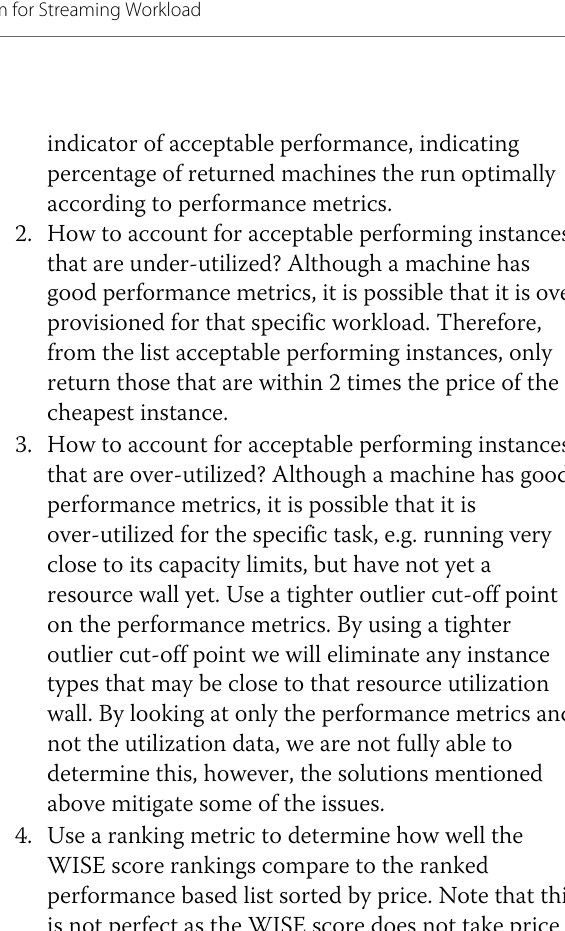
Fig. 11 WISE scores using the exponentially monotone function and (cid:4) 2 -norm for Streaming Workload